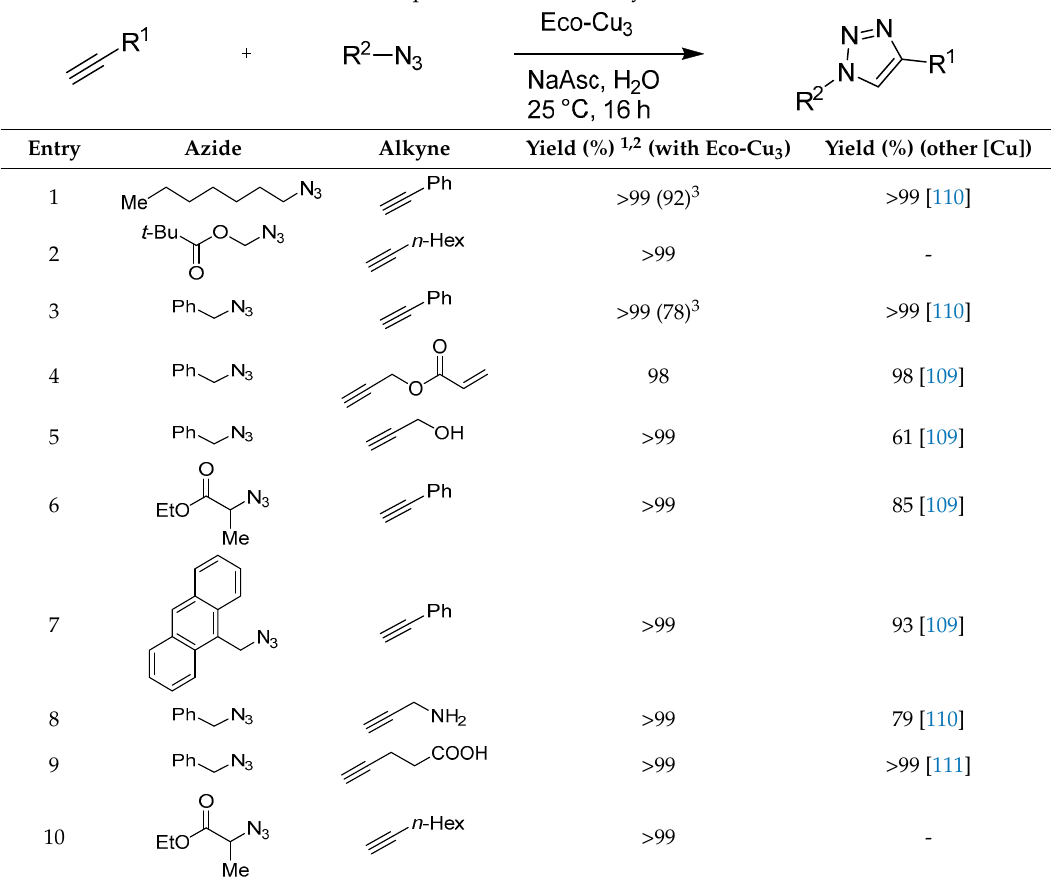
Table 11. A substrate scope of the Eco-Cu-catalysed CuAAC reaction.